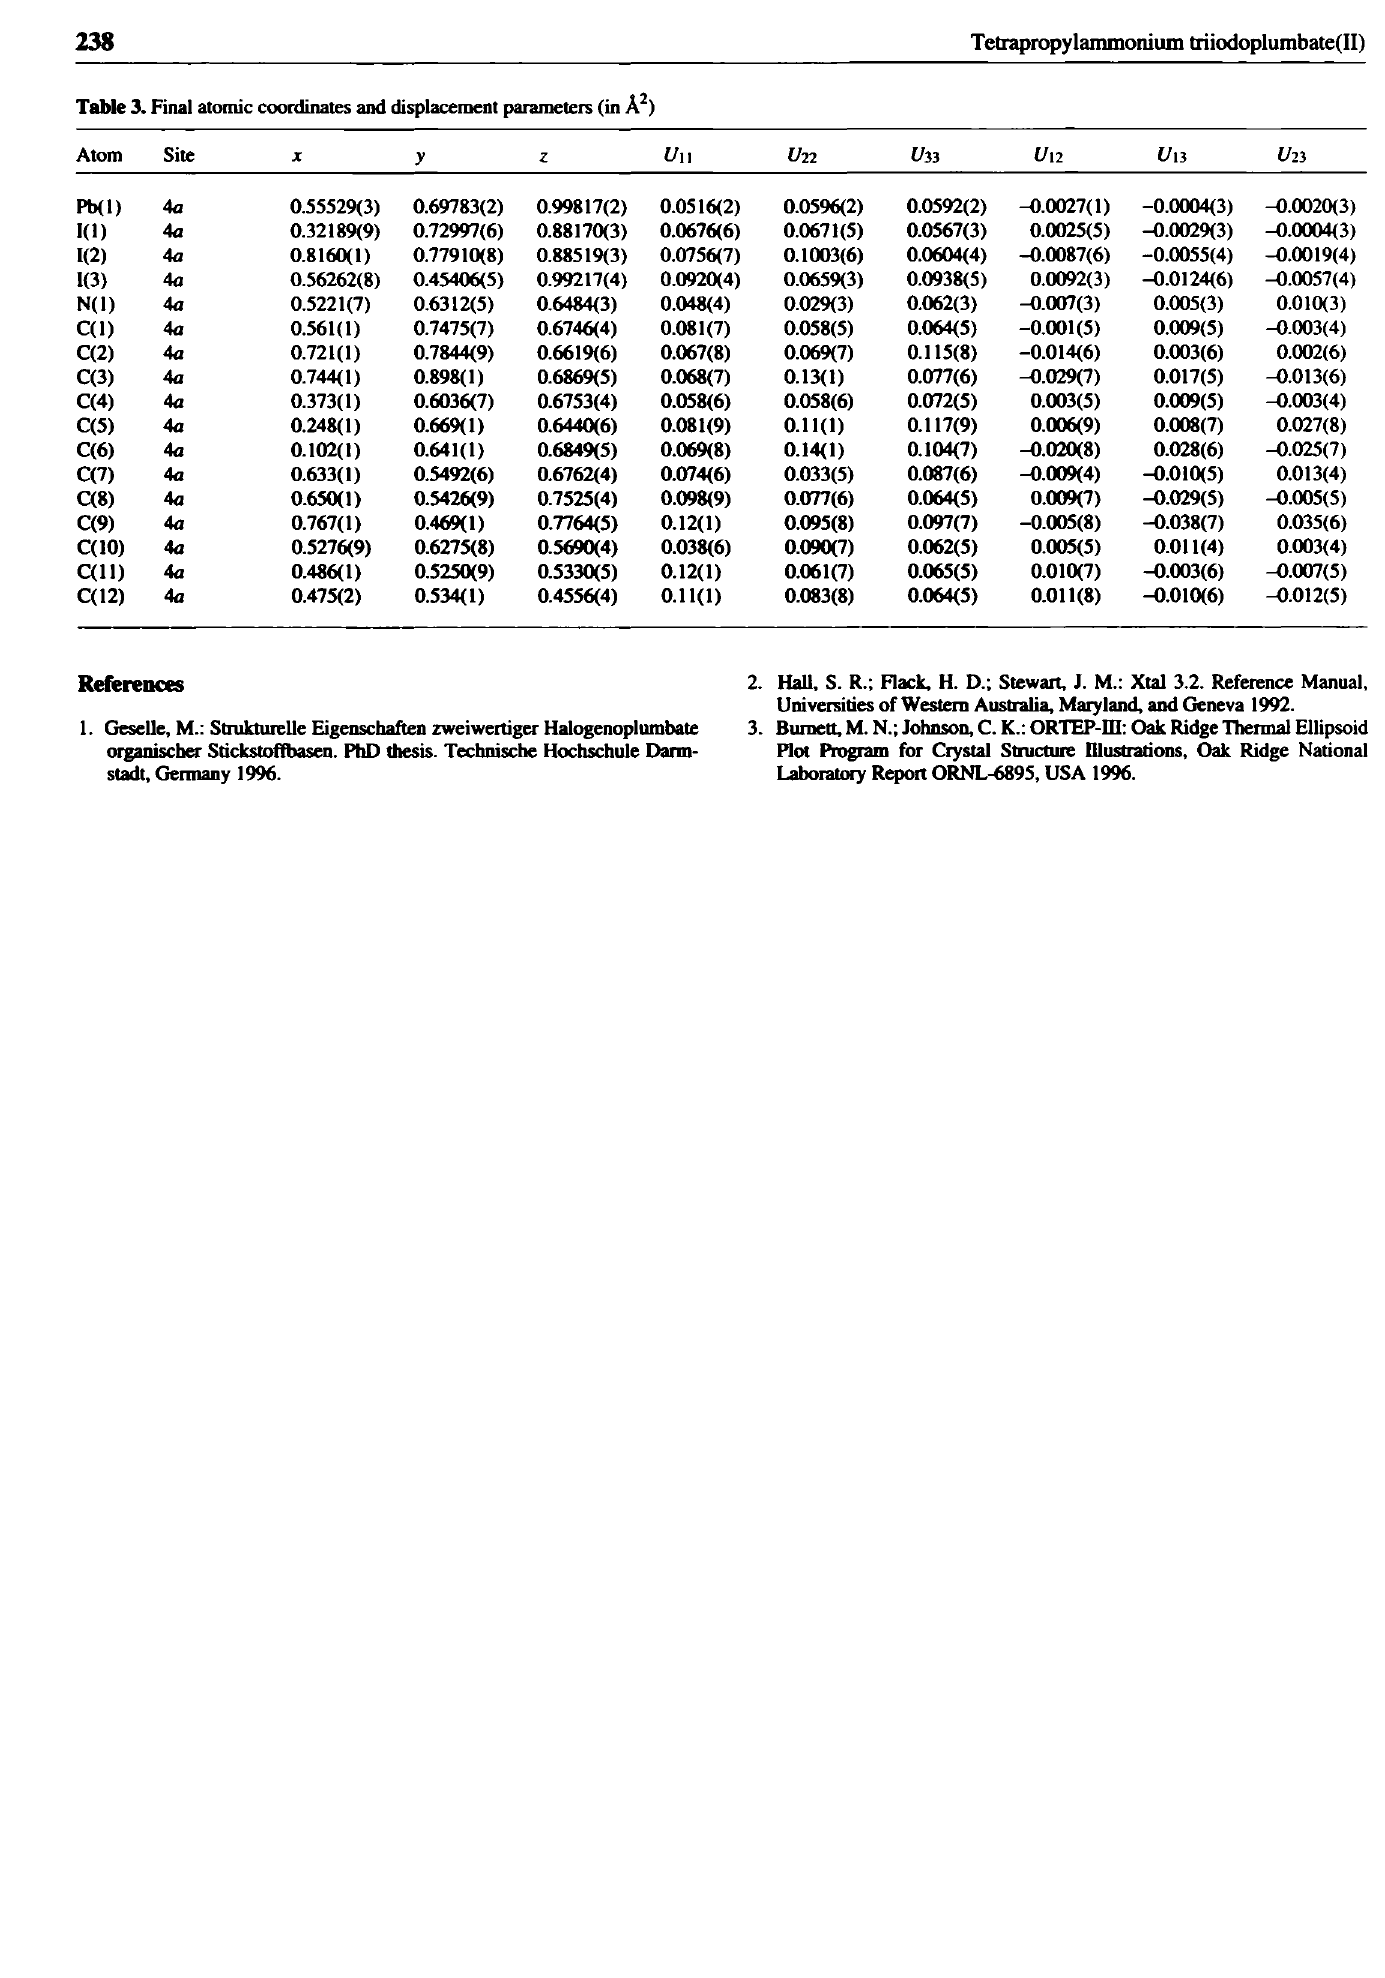
Table 3. Final atomic coordinates and displacement parameters (in Â 2